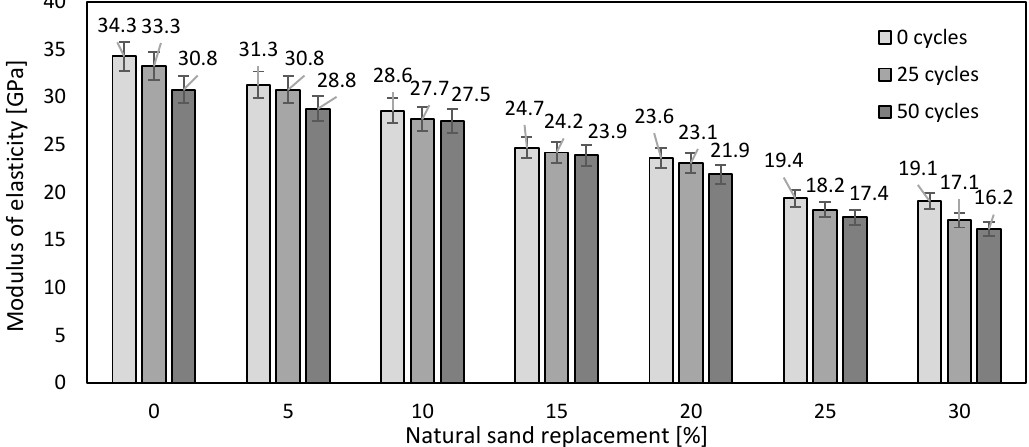
have relevance for the determination of final freeze-thaw resistance, thus flexural strength, Figure 8.